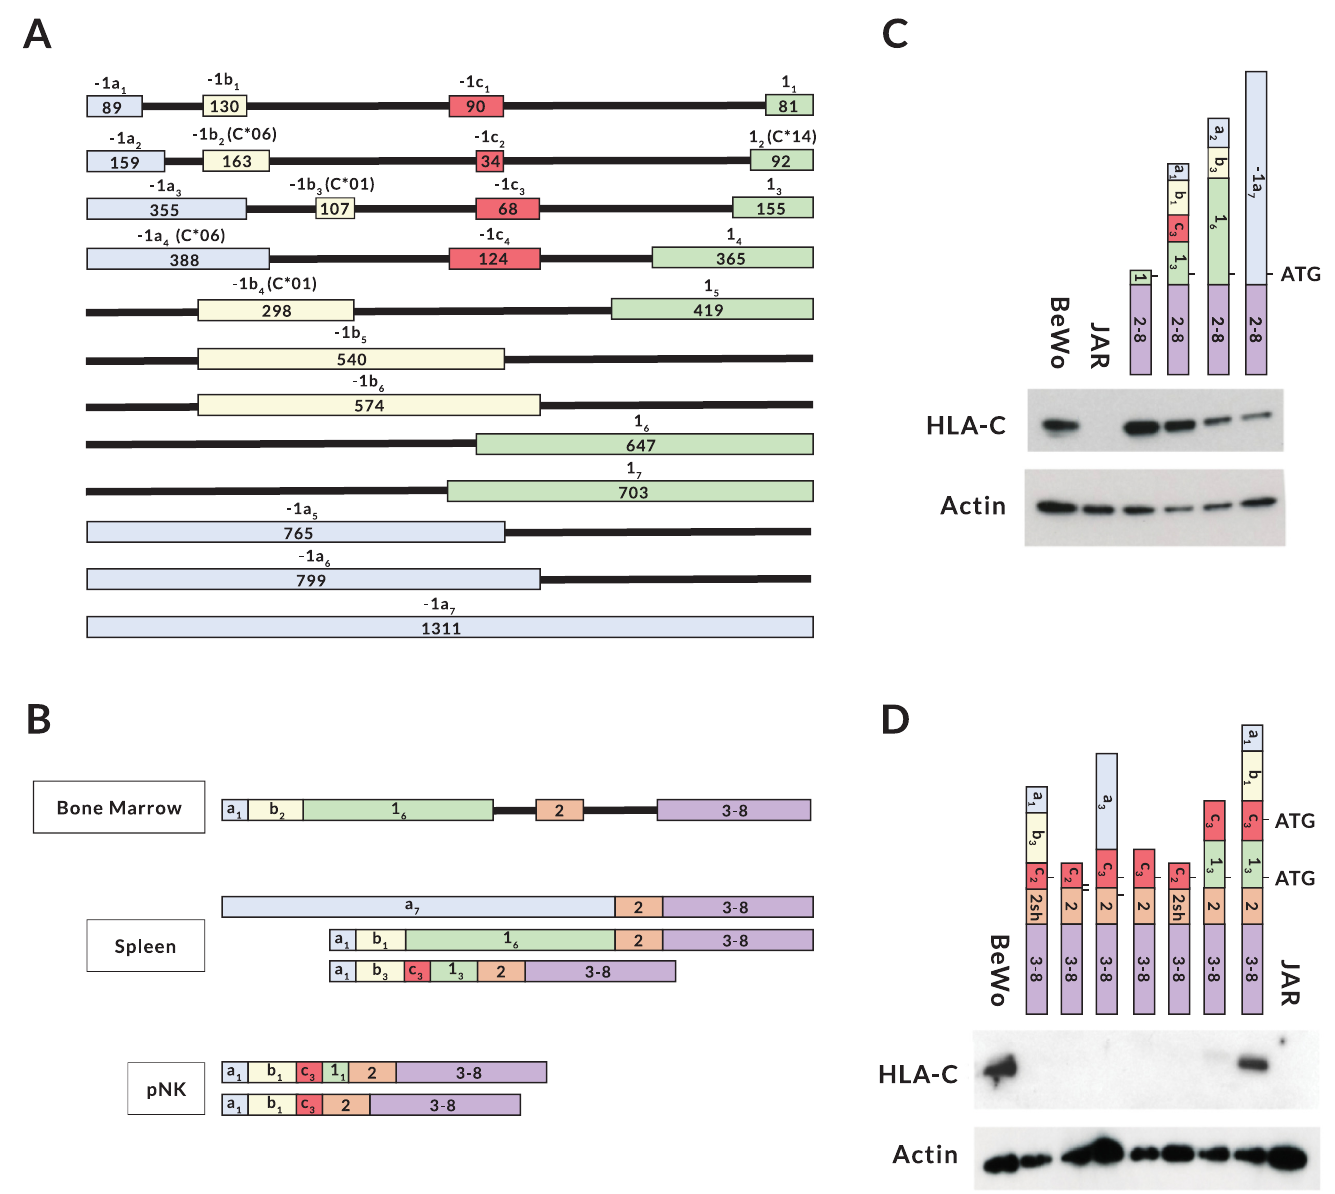
Fig 4. Variable exon content, tissue-specific splicing, and translatability of NK-Pro transcripts. (A) A schematic summarizing alternative exons detected in NK-Pro transcripts is shown. The three non-coding exons resulting from transcription initiating at NK-Pro are named as exons -1a, -1b, and -1c, with subscripts indicating the multiple variants of each exon. Allele-specific exons are indicated in parentheses. (C (cid:3) 01) indicates an exon found in the HLA-C (cid:3) 01 or C (cid:3) 04 alleles. (C (cid:3) 06) represents an exon from the HLA-C (cid:3) 06 / (cid:3) 12 alleles. (C (cid:3) 14) is an exon found in the HLA-C (cid:3) 01 , C (cid:3) 03 , C (cid:3) 04 , and C (cid:3) 14 alleles. The length of each exon is indicated. (B) A schematic of tissue-associated splice forms is shown for bone marrow, spleen, and peripheral blood NK cells (pNK). The most abundant transcripts are shown for bone marrow and pNK. The tissue-specific splice forms are shown for spleen. (C) Western blot of JAR cells transfected with expression constructs containing different lengths of 5´-UTR. Exon content of transfected cDNAs is shown schematically above each lane. HLA-C expressing BeWo cell lysate is shown on the left, followed by untransfected JAR cell lysate. (D) Western blot of JAR cells transfected with expression constructs lacking exon 1. The cDNA construct transfected is indicated schematically above each lane. BeWo cell lysate is shown in the left lane, and untransfected JAR cell lysate is on the right.